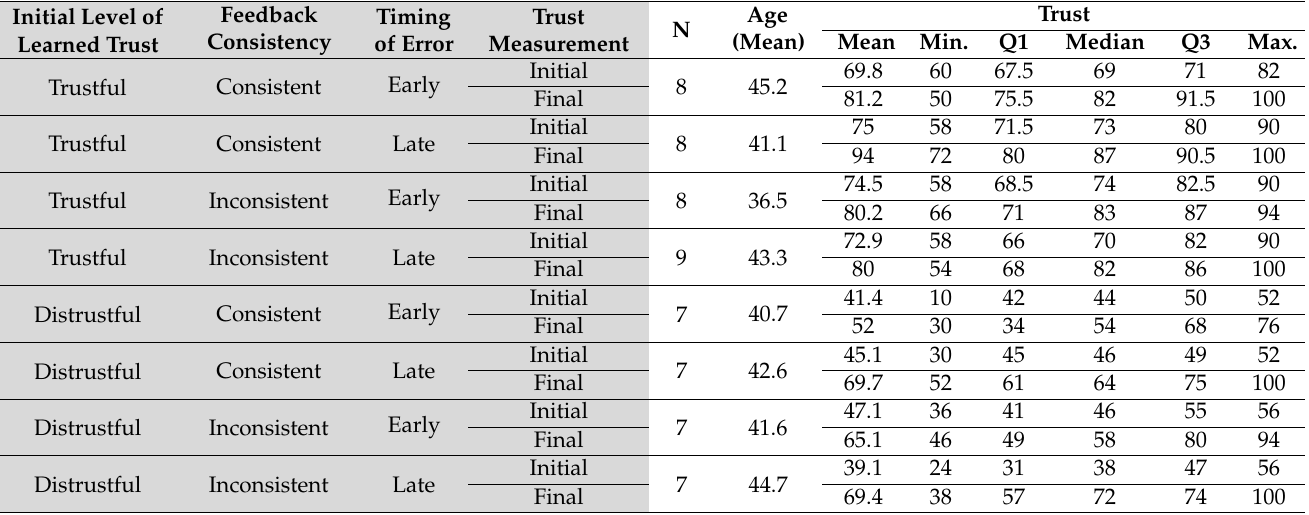
Table 2. Participants’ initial and final level of trust. Q1 and Q3 are the first and third quartiles.